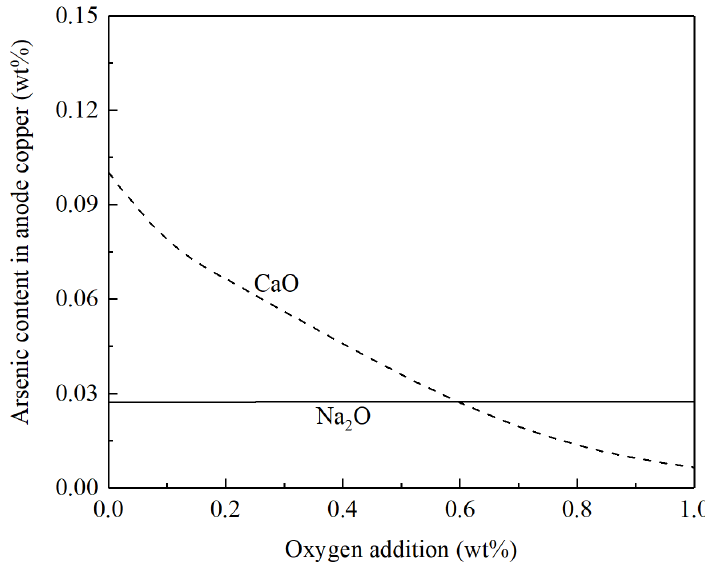
Figure 8. Effect of O 2 /blister on arsenic content in anode copper with 0.5% flux/blister. Effect of temperature on arsenic content in anode copper is shown in Figure 9 with 0.2% flux addition. It can be seen that at lower temperature, the arsenic content in anode copper can be reduced with increasing the temperature. The effect of temperature on ar- senic content in anode copper is not significant at high temperatures and high flux addi- tions. Figure 9. Effect of temperature on arsenic content in anode copper with 1.5% O 2 /blister and 0.2% flux/blister. Figure 10 shows the effect of flux addition on arsenic distribution at 1200 °C with O 2 addition 1.5%. It can be seen that CaO is a better flux than Na 2 O in the removal of arsenic if oxygen is added which is the condition of oxidation stage in the fire refining process. With 0.55% CaO or Na 2 O addition, over 99% arsenic brought from blister can be removed in the slag phase and a clean anode copper is obtained. The molecular mass of Na 2 O (61.98) is larger than the molecular mass of CaO (56.08). When the same weight of Na 2 O